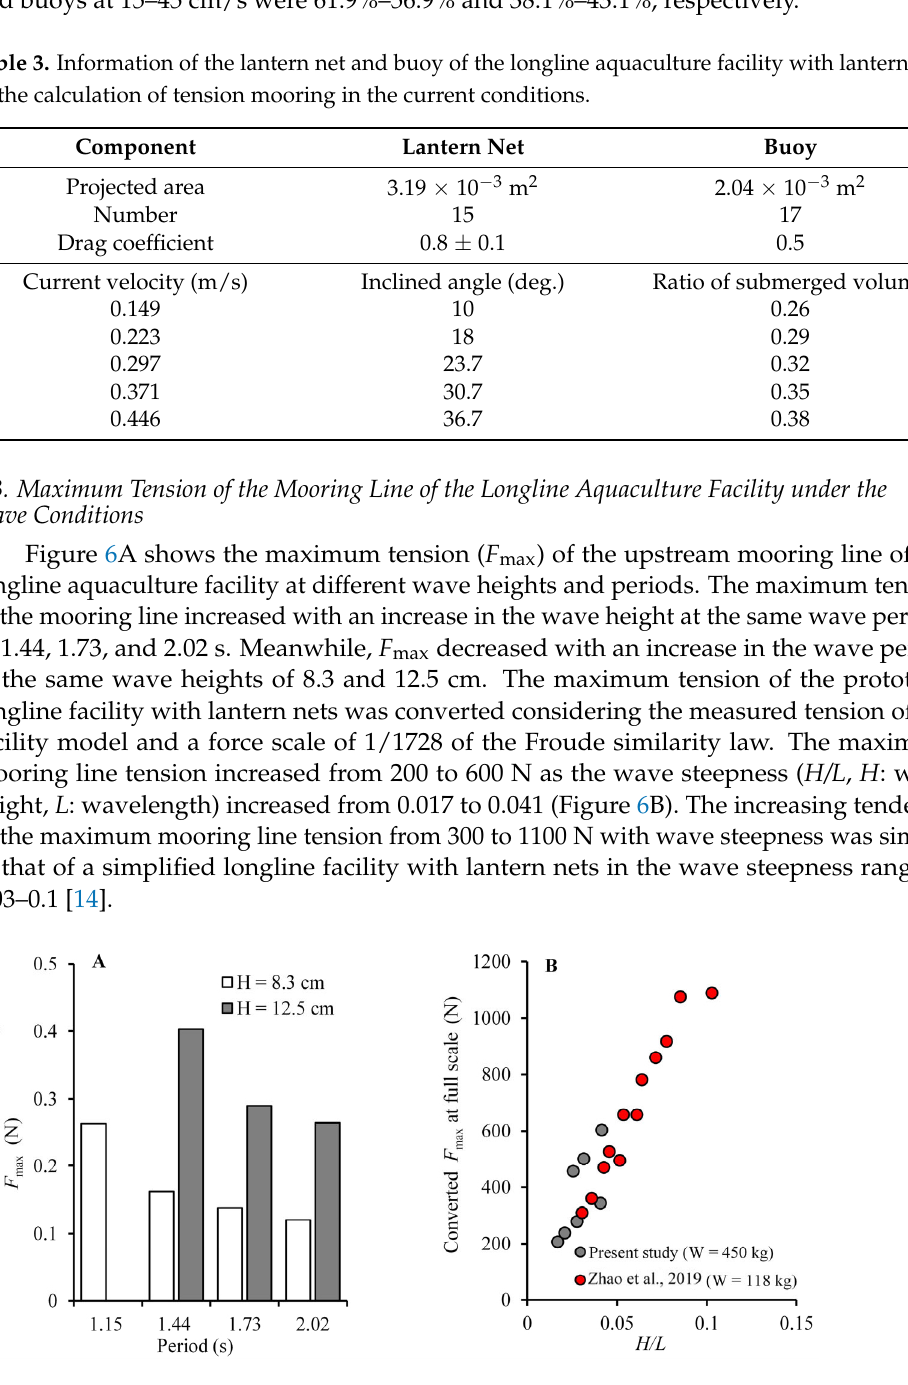
Figure 6. ( A ) Maximum tension of mooring line F max of the longline aquaculture facility model with lantern nets in the wave conditions at wave periods of 1.15–2.02 s and wavelengths L of 8.3 and 12.5 cm. ( B ) Relationship between converted F max at full scale of the longline aquaculture facility with lantern nets and the values of H/L from 0.01 to 0.1 (H: wave height)